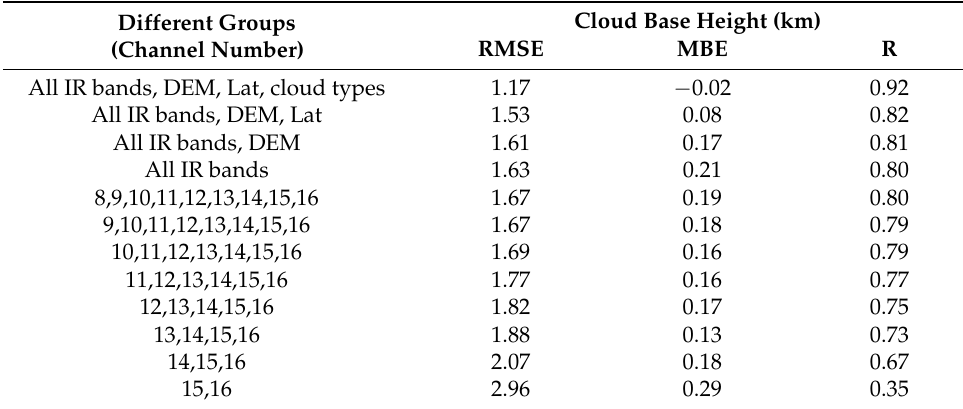
Figure 2. Scatter plots of H-8 infrared band vs. cloud geometric thickness. Table 2. Different input groups and their validation of CBH